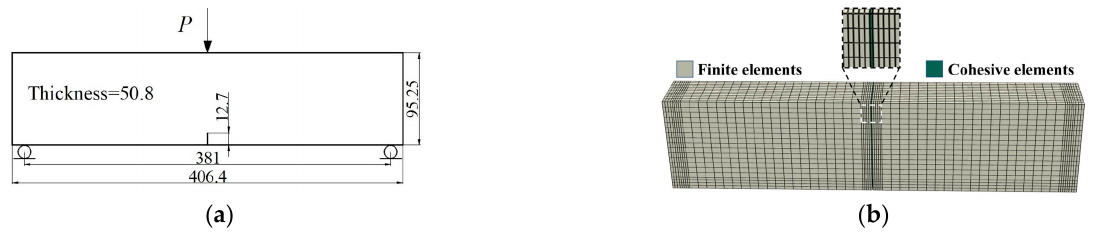
Figure 3. Load history used for the impact test.